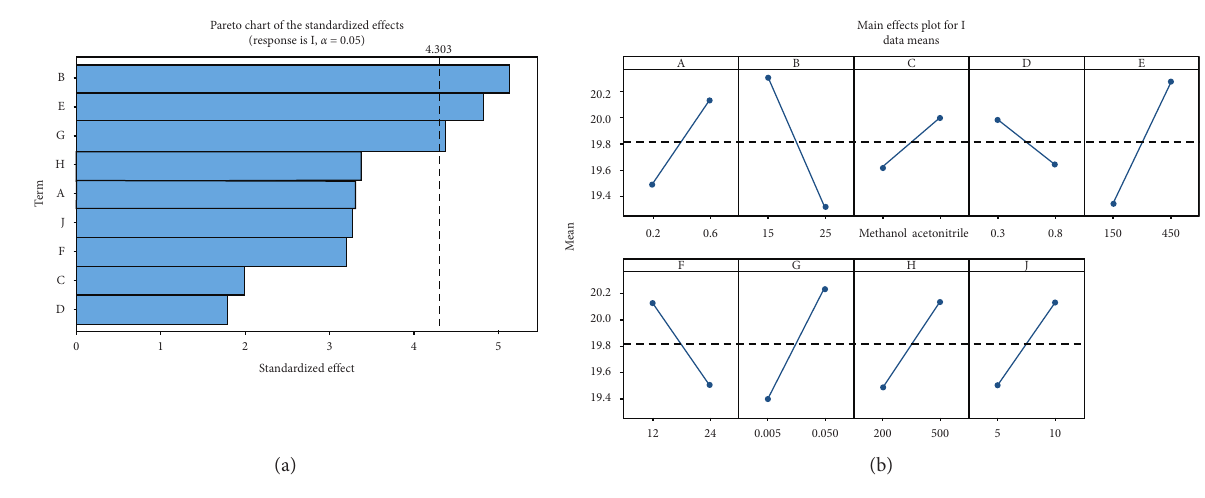
Figure 1: (a) The Pareto plot; (b) the main effect plot. Table 2: The CCD matrix and the experimental results. Run order